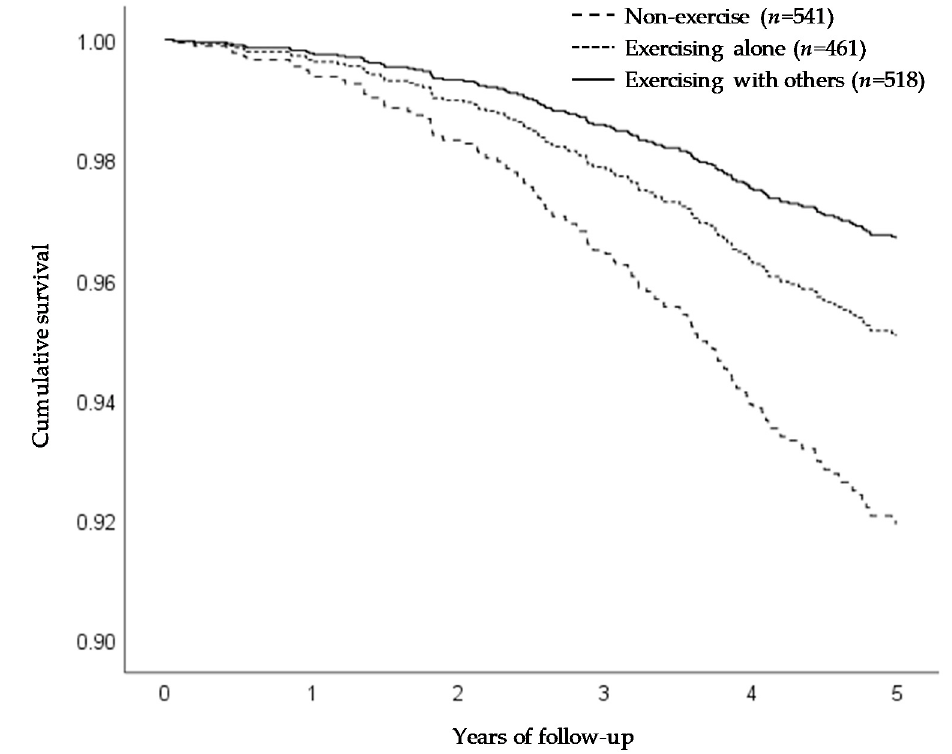
Figure 2. Adjusted Kaplan–Meier curves for morality by exercise pattern. Survival curves were adjusted for age, gender, body mass index, living arrangement, subjective economic condition, medical history, fall history, and depressive symptoms.